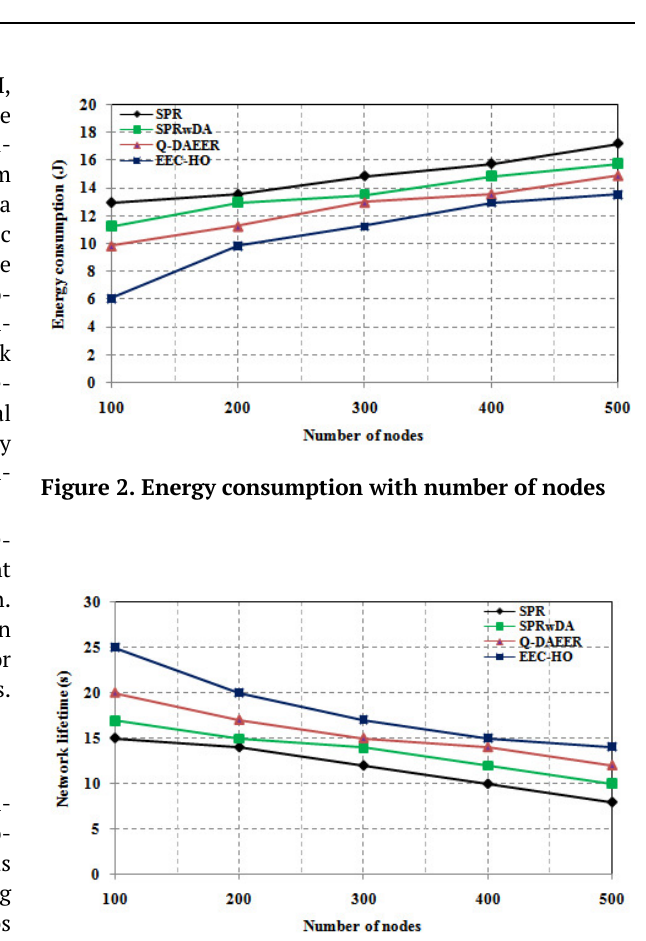
Figure 3. Network lifetime with number of nodes